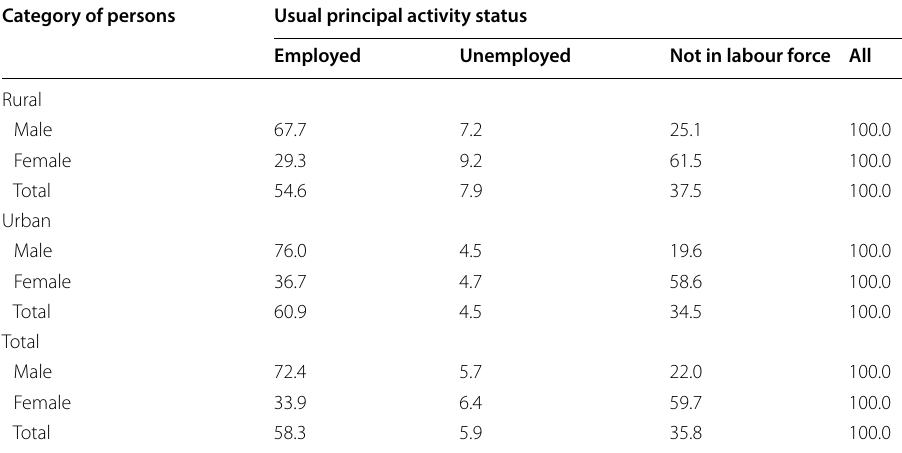
Table 4 Broad usual principal activity status of those who received/were receiving formal vocational training (Percent) Source: NSSO